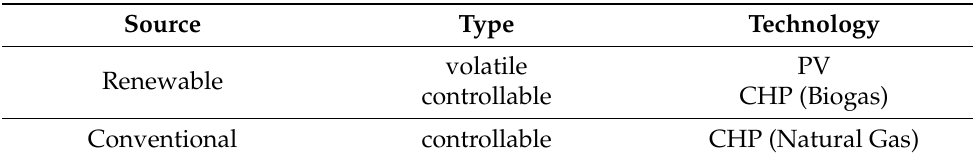
Table 3. Implemented generation